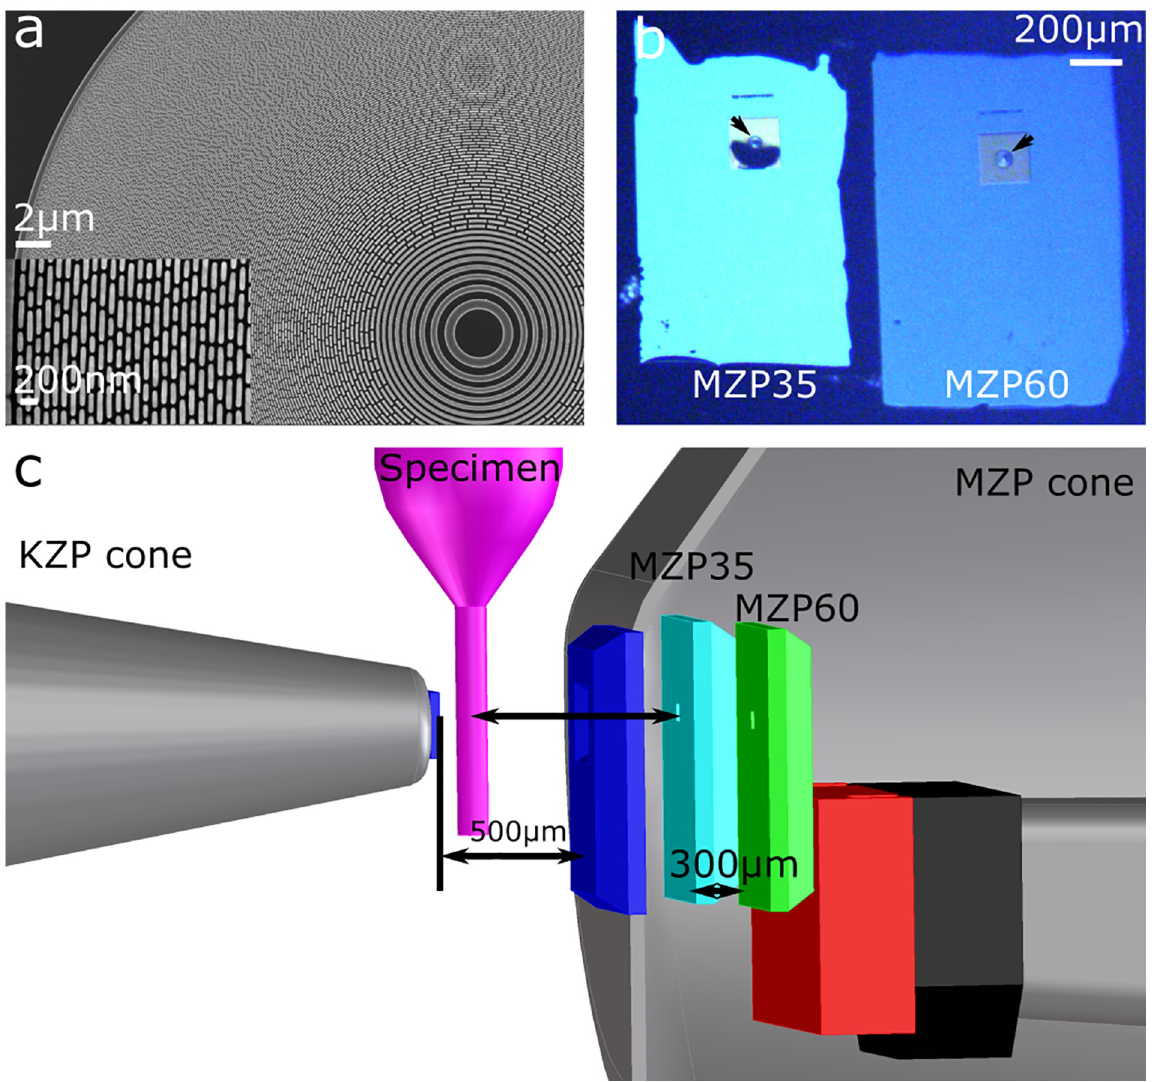
Fig 1. X-ray optics. (a) Scanning electron microscope images of the MZP with 35 nm outermost zone width. (b) Image of mounted MZPs acquired in reflection mode of the visible light microscope positioned the along optical axis at XM-2. The dark blue region below 35 nm MZP arises from a knickpoint in the supporting membrane. The arrows show the location of the MZPs. (c) Main optical components and their respective distances in a 3D mechanical drawing of XM-2: KZP cone—condenser zone plate located inside the steel cone; dark blue—pinholes before and after the specimen; pink—capillary with specimens; cyan and green—MZPs; red—the magnetic holder for MZPs; black—the magnetic holder positioned at the stage; MZP cone denotes the steel cone containing MZPs.